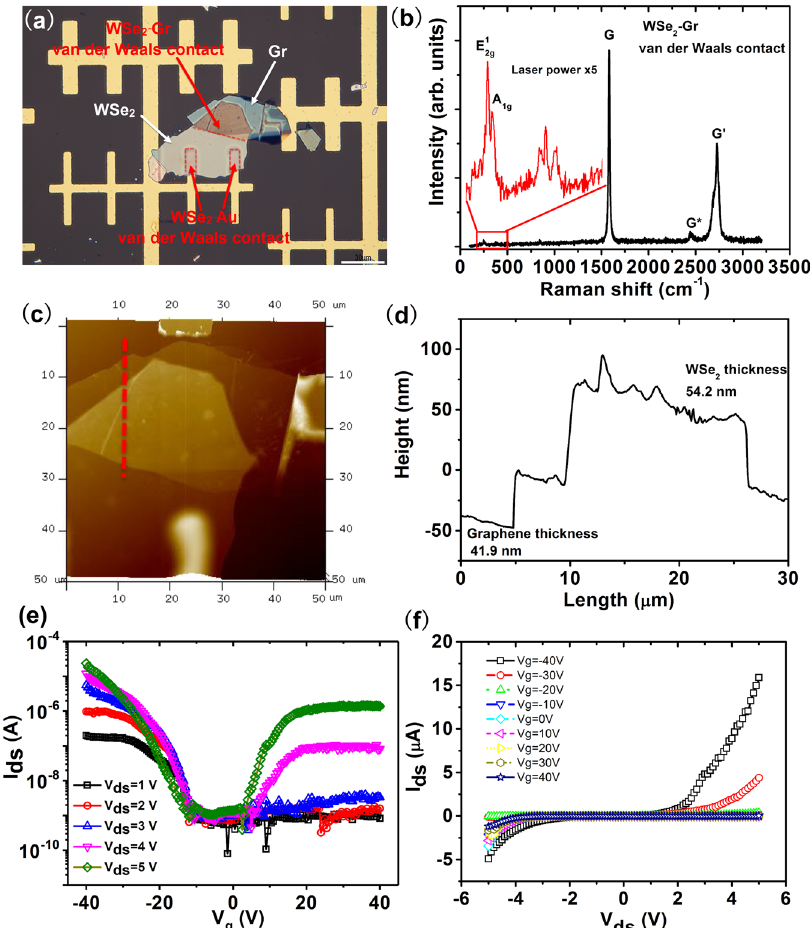
Fig. 2 Device fabrication and basic electrical characteristics. a Optical picture of one fabricated graphene – WSe 2 – Au structure by the dry- transfer process. The red dashed lines indicate the boundary of the van der Waals contacts. Scale bar 30 μ m. b Raman spectrum obtained on the multilayer graphene – WSe 2 contact region. For the lower Raman shift range, the laser power is increased to fi ve times to identify the WSe 2 characteristics. The excitation wavelength is 532 nm. c Atomic force microscope image of the fabricated graphene – WSe 2 – Au structure. c . e Transfer curves and f output curves of the fabricated d Height pro fi le of the graphene – WSe 2 heterostructure along the red dashed line in graphene –